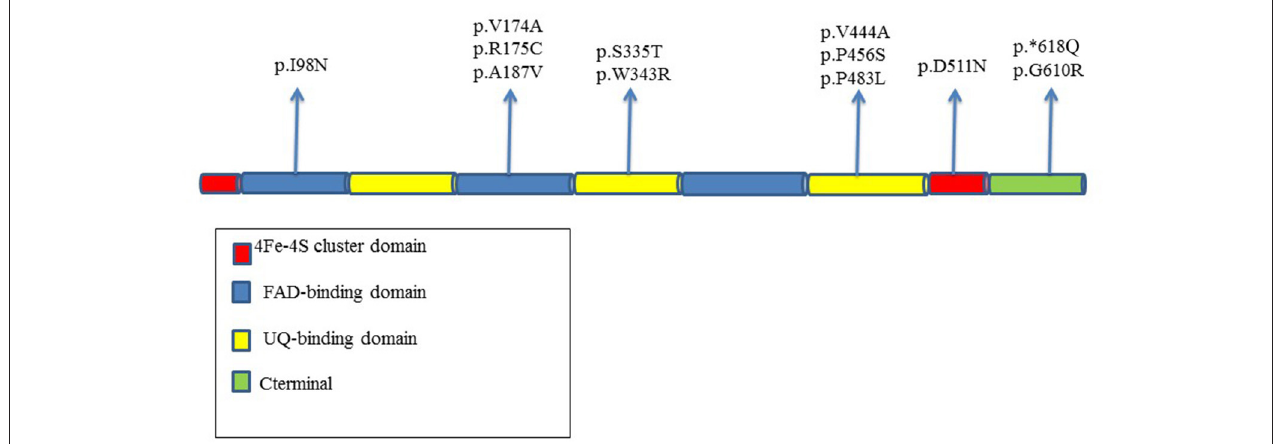
FIGURE 4 | Distribution in the different domains of the protein of ETFDH variants reported in our MADD